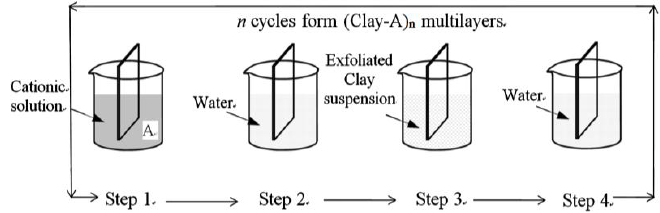
Figure 1. Schematic illustration of the clay-based nanostructured multilayer process (two-phase film).